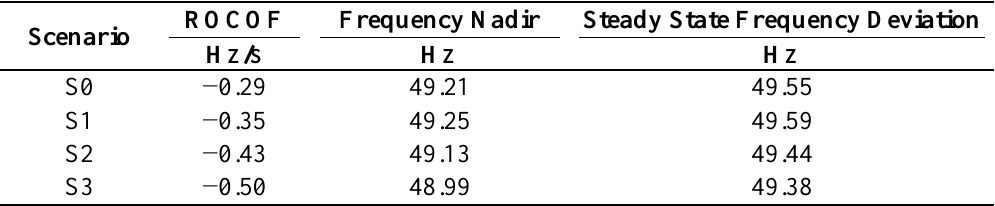
Table 3. Security Indices: PV-PPs with FFR capability, deload margin of 3%.